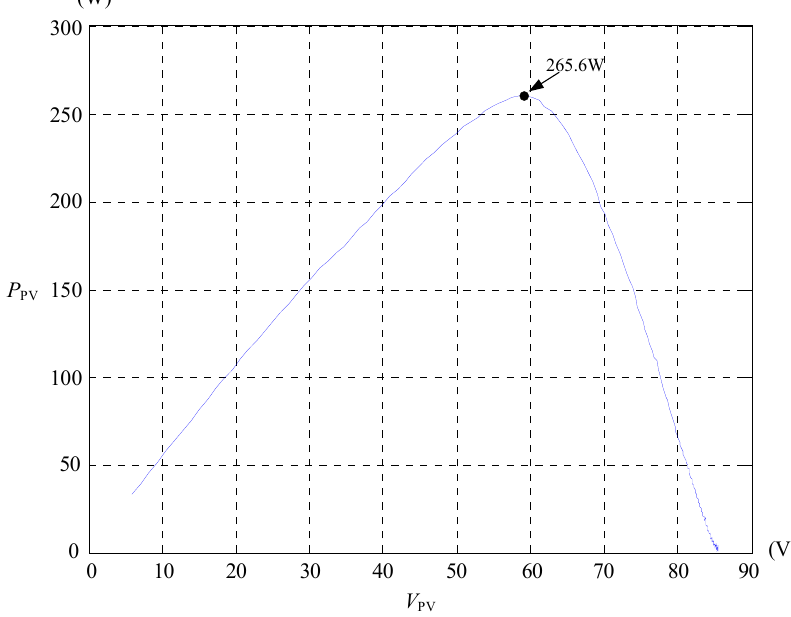
Figure 8. A single experimental P–V characteristic curve for all optimized configurations in Case 4.